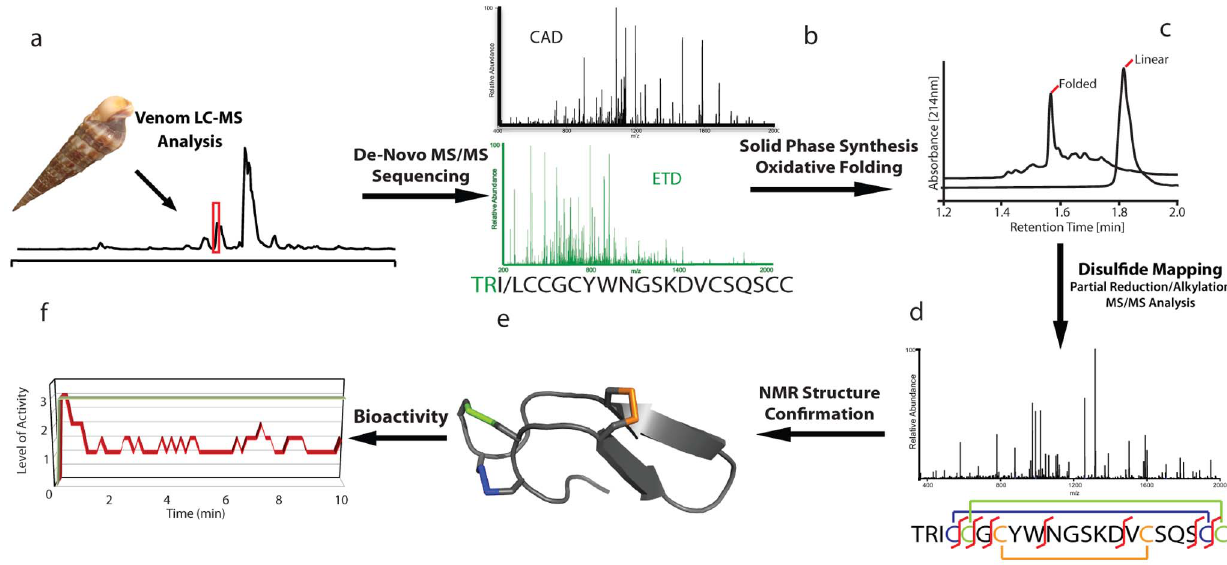
Figure 1. Discovery and characterization of disulfide–rich Tv1 teretoxin. An integrated approach for characterizing sample limited disulfide peptidic natural products was applied: a) RP-HPLC on-line separation of Terebra variegata venom (highlighted is the region where the sequenced peptide eluted). b) ETD and CAD MS/MS analysis recorded on the native peptide to determine the sequence of Tv1 peptide. c) RP-HPLC of linear and folded versions of chemically synthesized Tv1 peptide. d) MS/MS spectrum of partially reduced and alkylated Tv1 used to determine the disulfide connectivity. e) NMR solution structure of folded Tv1 peptide. f) Bioactivity of 20 m M of Tv1 ( 2 ) versus normal saline (NS) ( 2 ) solution injected into polychaete worms. Y-axis indicates level of activity, where 3 is the normal activity of the NS injected worm, 1 and 2 indicate decreased activity due to partial paralysis.